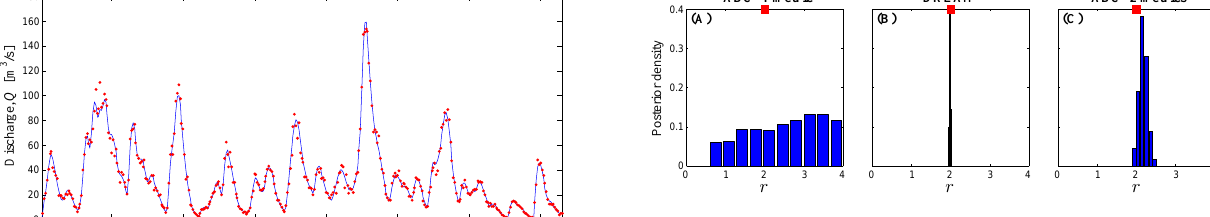
Fig. 3. Posterior distribution of the recession parameter derived from (A) ABC using the mean of the data as summary metric, (B) DREAM using a heteroscedastic measurement error, and (C) ABC using the mean and standard deviation of the data as summary statistics. The true parameter value is indicated with the red